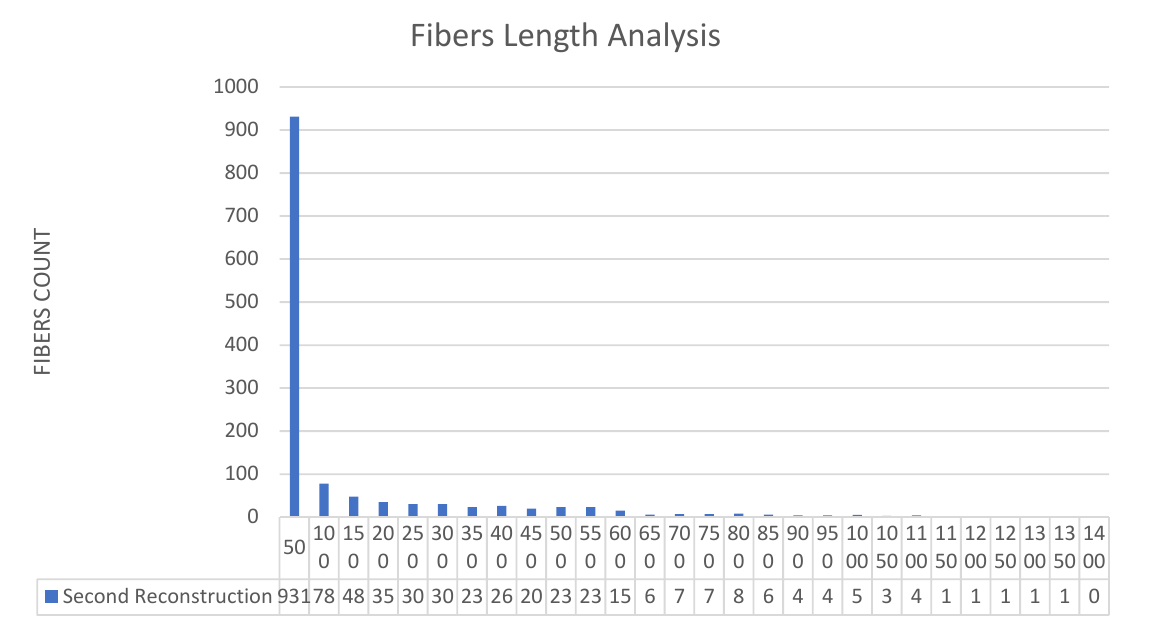
Figure 19. Statistical diagram of the polyester short fiber length reconstructed by Avizo software for the second time.